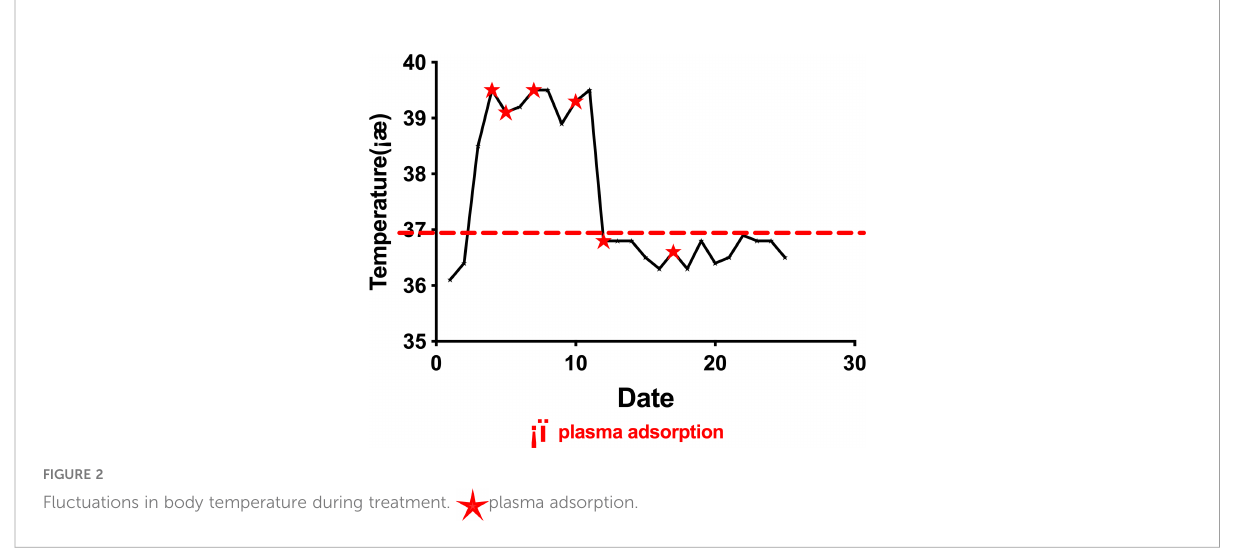
FIGURE 2 Fluctuations in body temperature during treatment. plasma